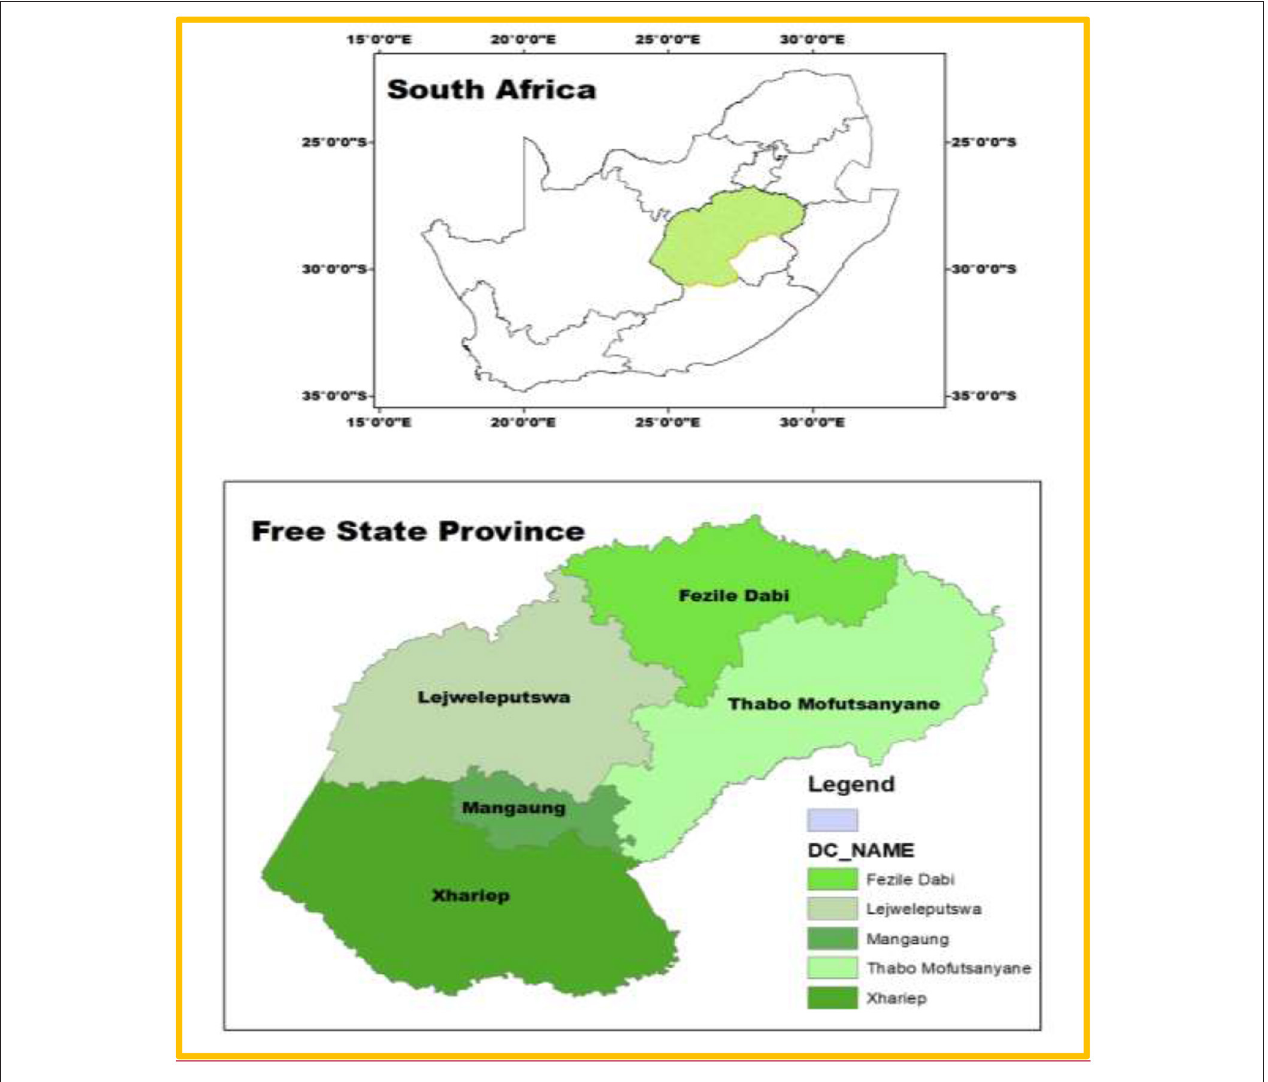
FIGURE 1 | Map of the study